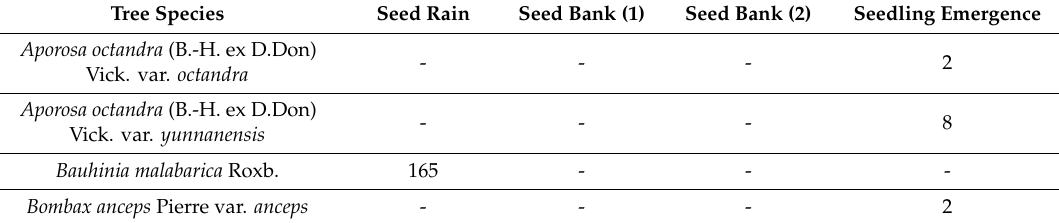
Table 1. Abundances of tree seeds or seedlings obtained from three di ff erent methods: seed rain, soil seed bank (two repetitions), and seedling emergence. Two varieties of Aporosa octandra were treated as two di ff erent species in this